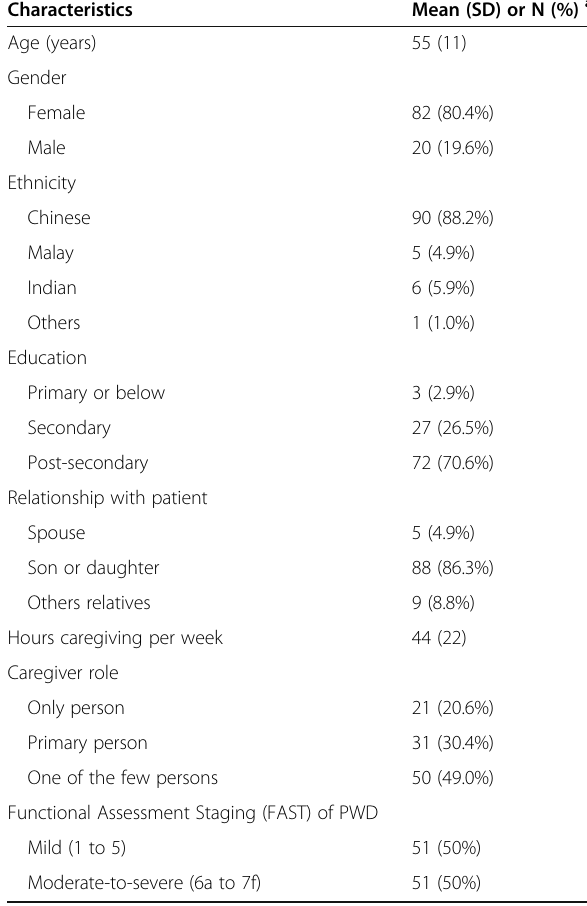
Table 2 Participant characteristics ( N = 102)